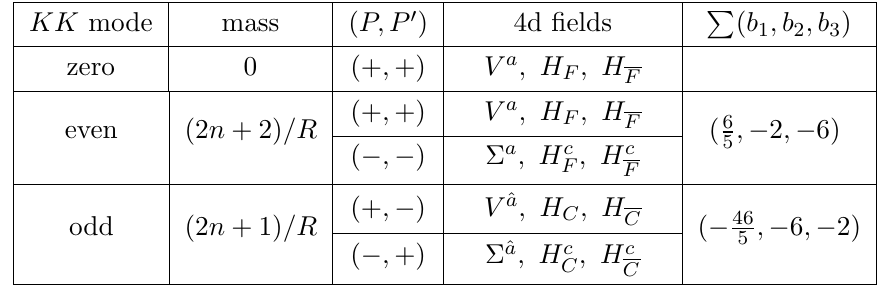
Table 4 . The orbifold parity assignment and contributions to the (cid:12) -function coe(cid:14)cients from the bulk (cid:12)elds. R is the compacti(cid:12)cation